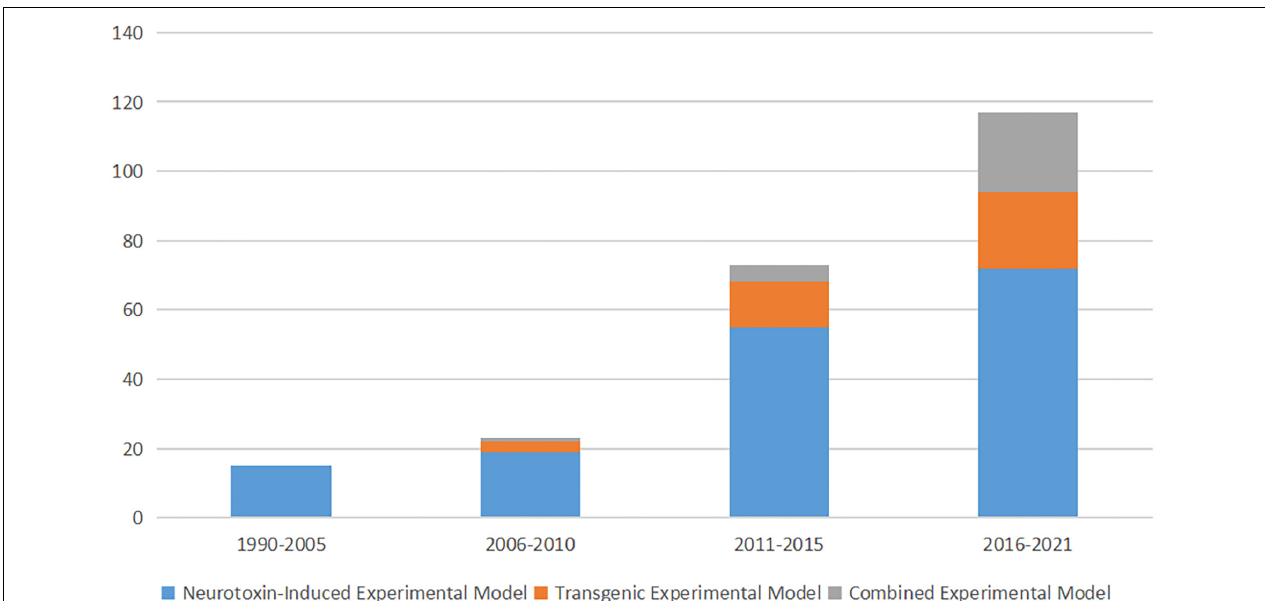
FIGURE 2 | Trends in experimental models of PD with cognitive